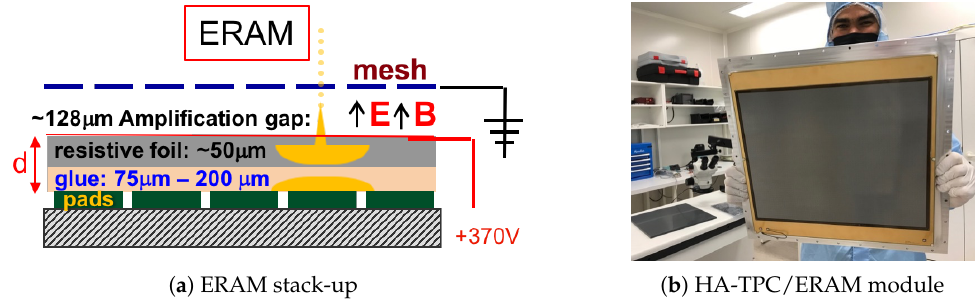
Figure 14. Encapsulated Resistive Anode Micromegas (ERAM) for the T2K/ND280 High-Angle TPCs. 6.2. MINOS